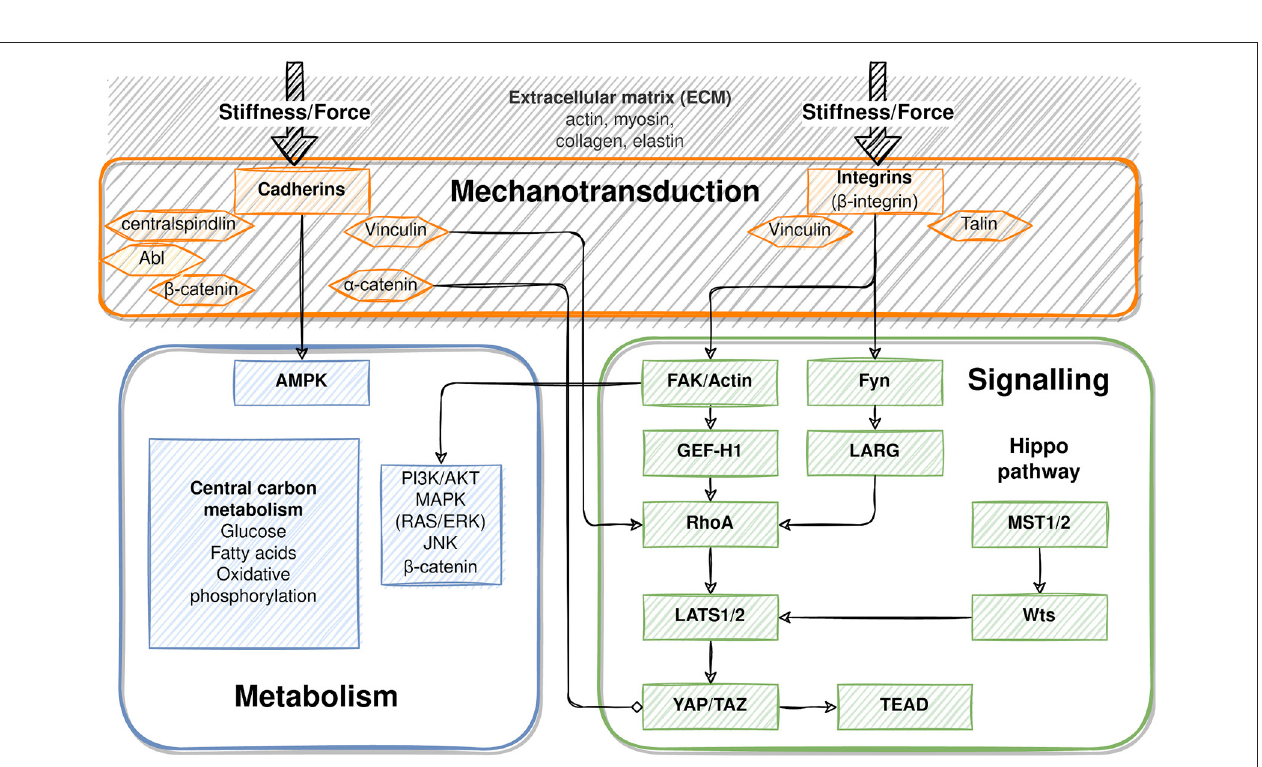
FIGURE 4 | Multiple scales relevant for computational modeling of perfusion-function relationships. Anatomograms under CC-BY Papatheodorou et al. (2020).